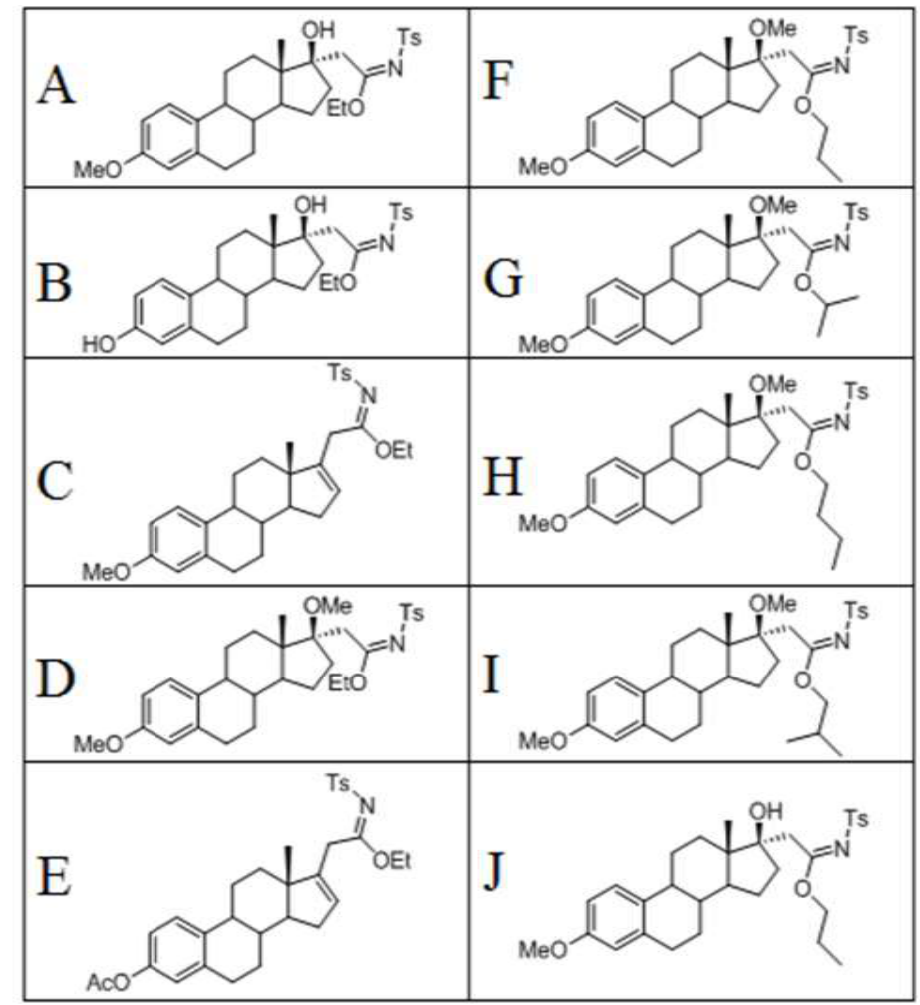
Figure 1. Steroid hormone